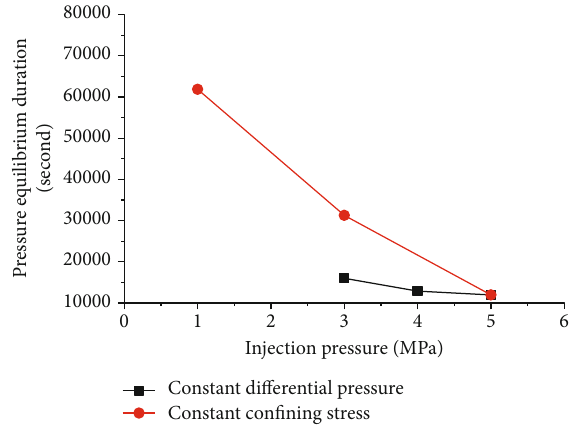
Figure 6: Durations of gas pressure equilibrium under di ff erent test conditions.